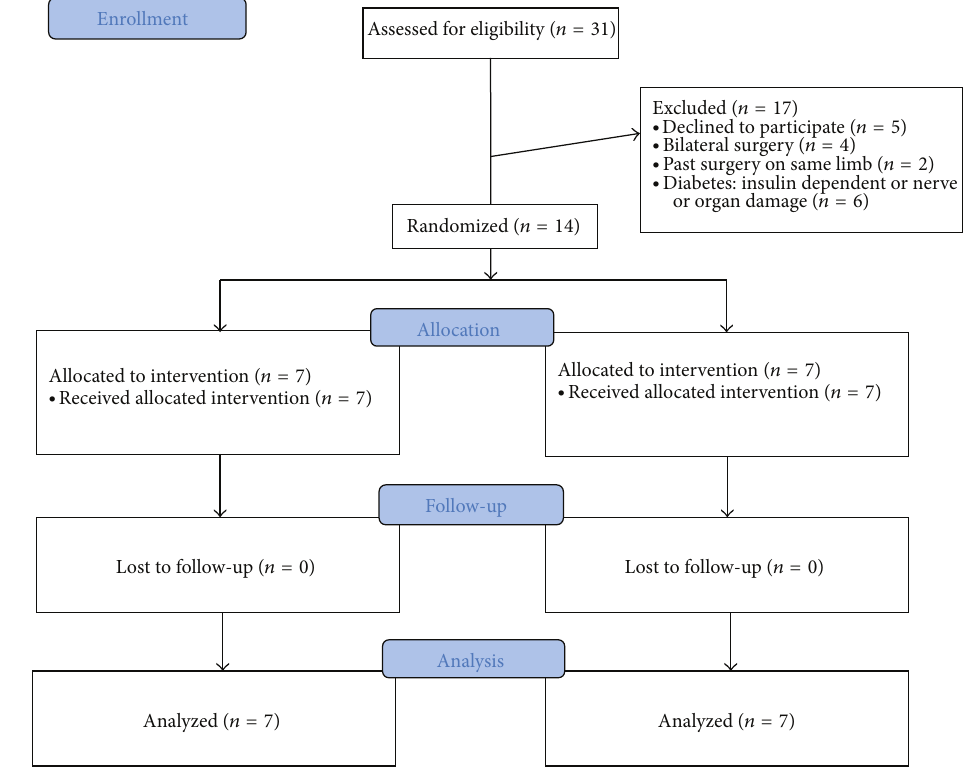
Figure 2: CONSORT study flow diagram. Table 2: Secondary outcomes